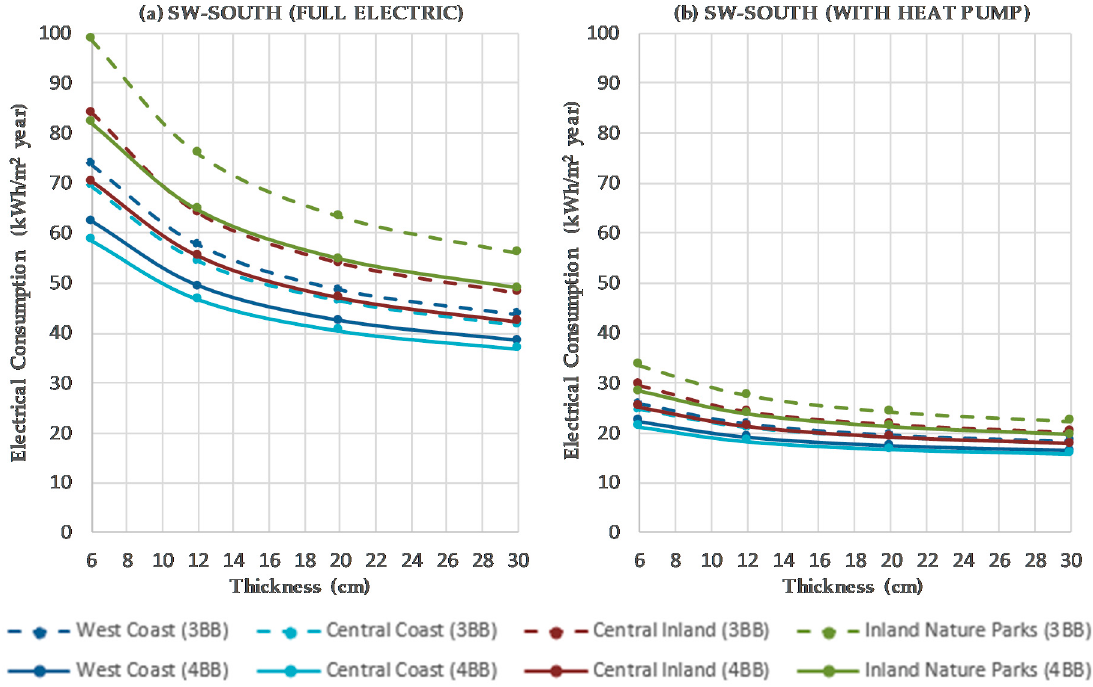
Figure 6. Electrical consumption according the insulation thickness for the four locations with SW-SOUTH for 4BB and for 3BB: ( a ) Electricity only; ( b ) Heat pump plus electricity.